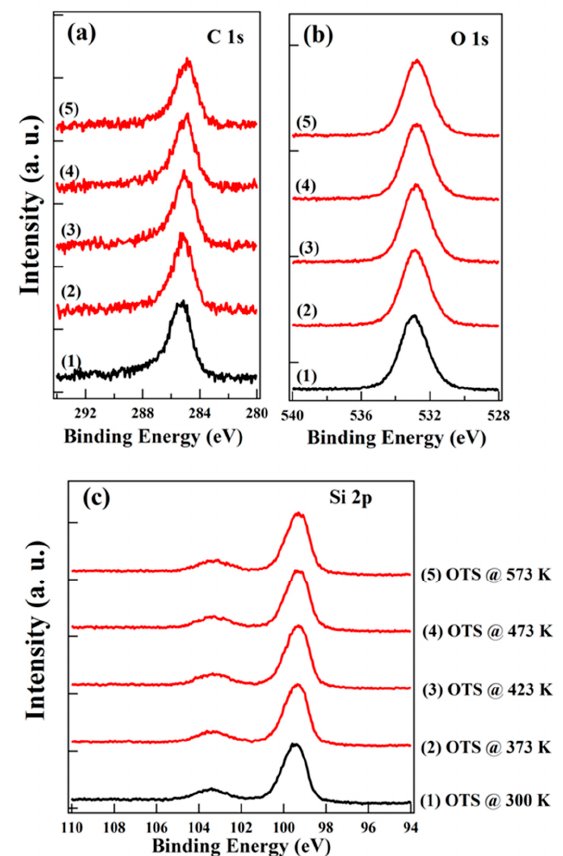
Figure 1. X-ray photoelectron spectroscopy (XPS) spectra of ( a ) C 1s, ( b ) O 1s, and ( c ) Si 2p for OTS as a function of vacuum annealing